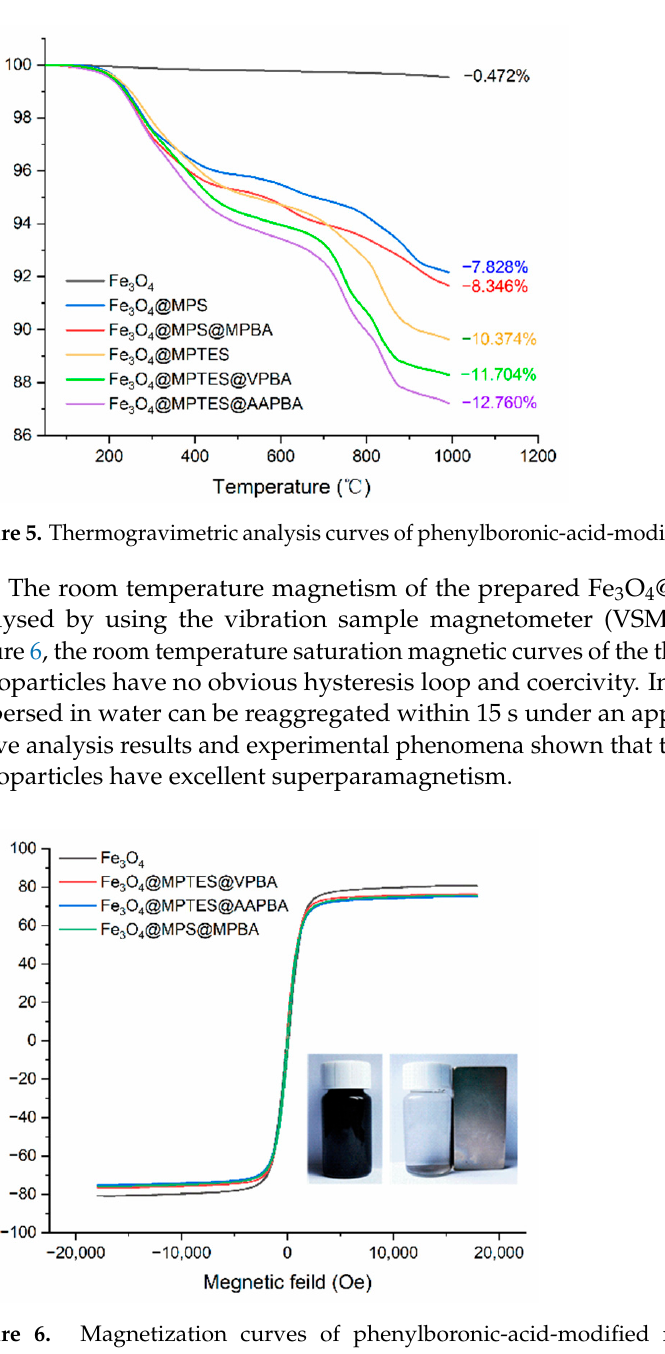
Figure 6. Magnetization curves of phenylboronic ‐ acid ‐ modified magnetic nanoparticles at room temperature.